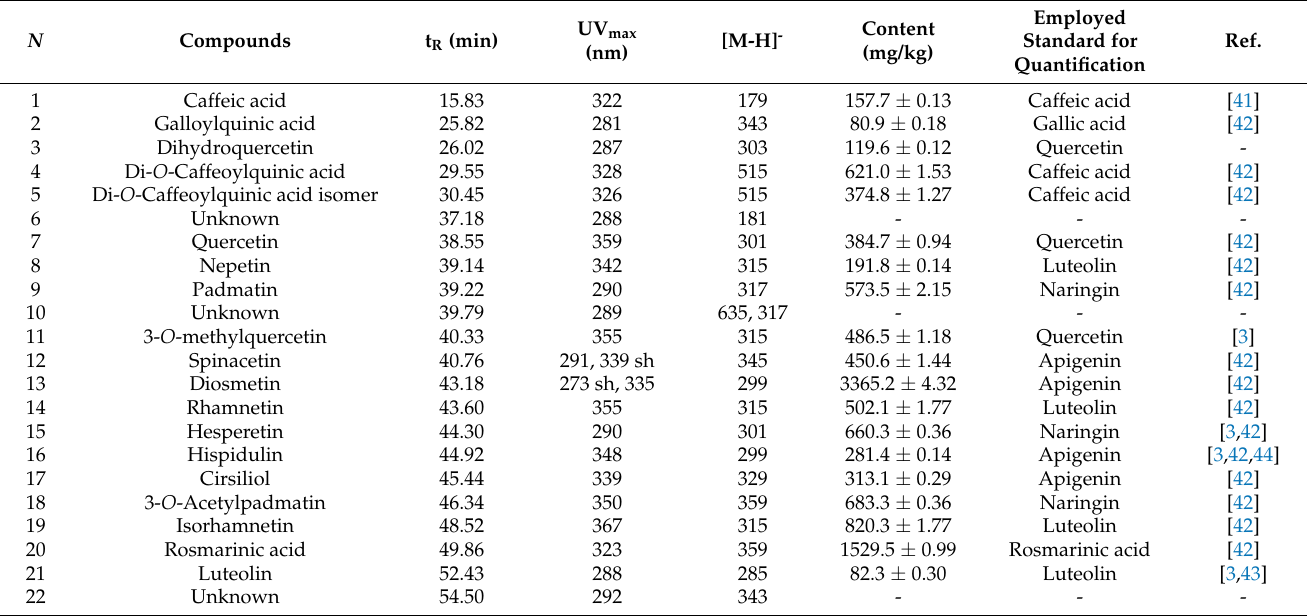
Figure 1. Polyphenolic profile of I. viscosa EtOAc extract by investigated by HPLC-DAD-ESI/MS (330 nm). Table 5. Polyphenolic compounds detected in I. viscosa EtOAc extract by